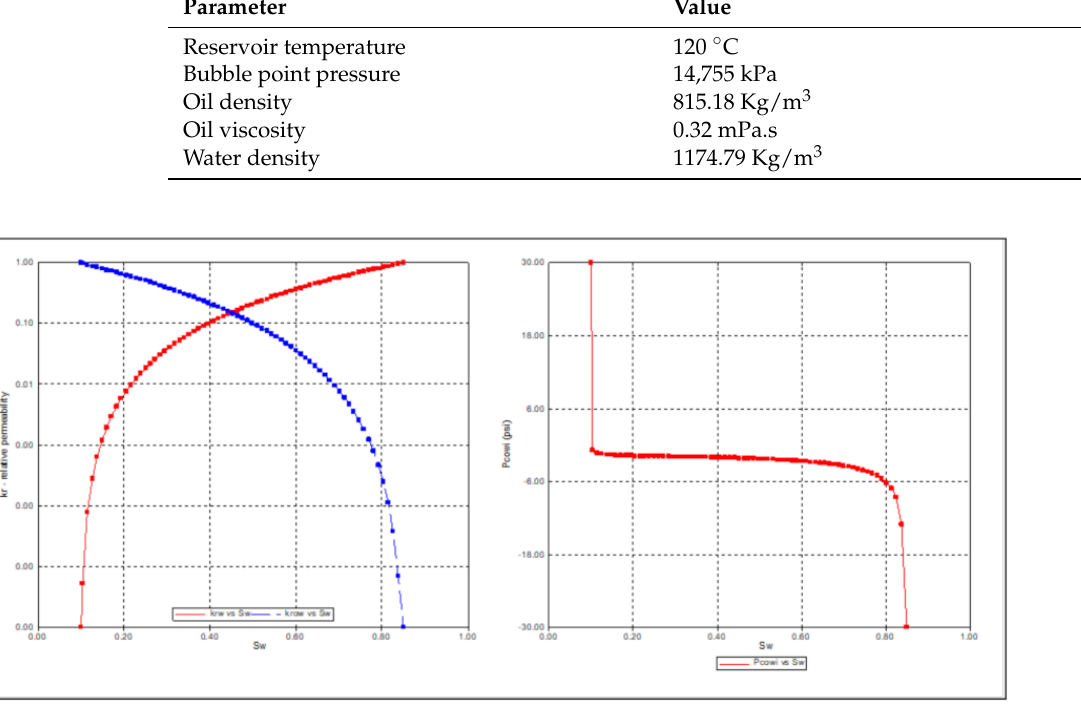
Figure A1. Oil-water relative permeability and capillary pressure curves for permeability above 100 mD (Modified and adapted from [21]).